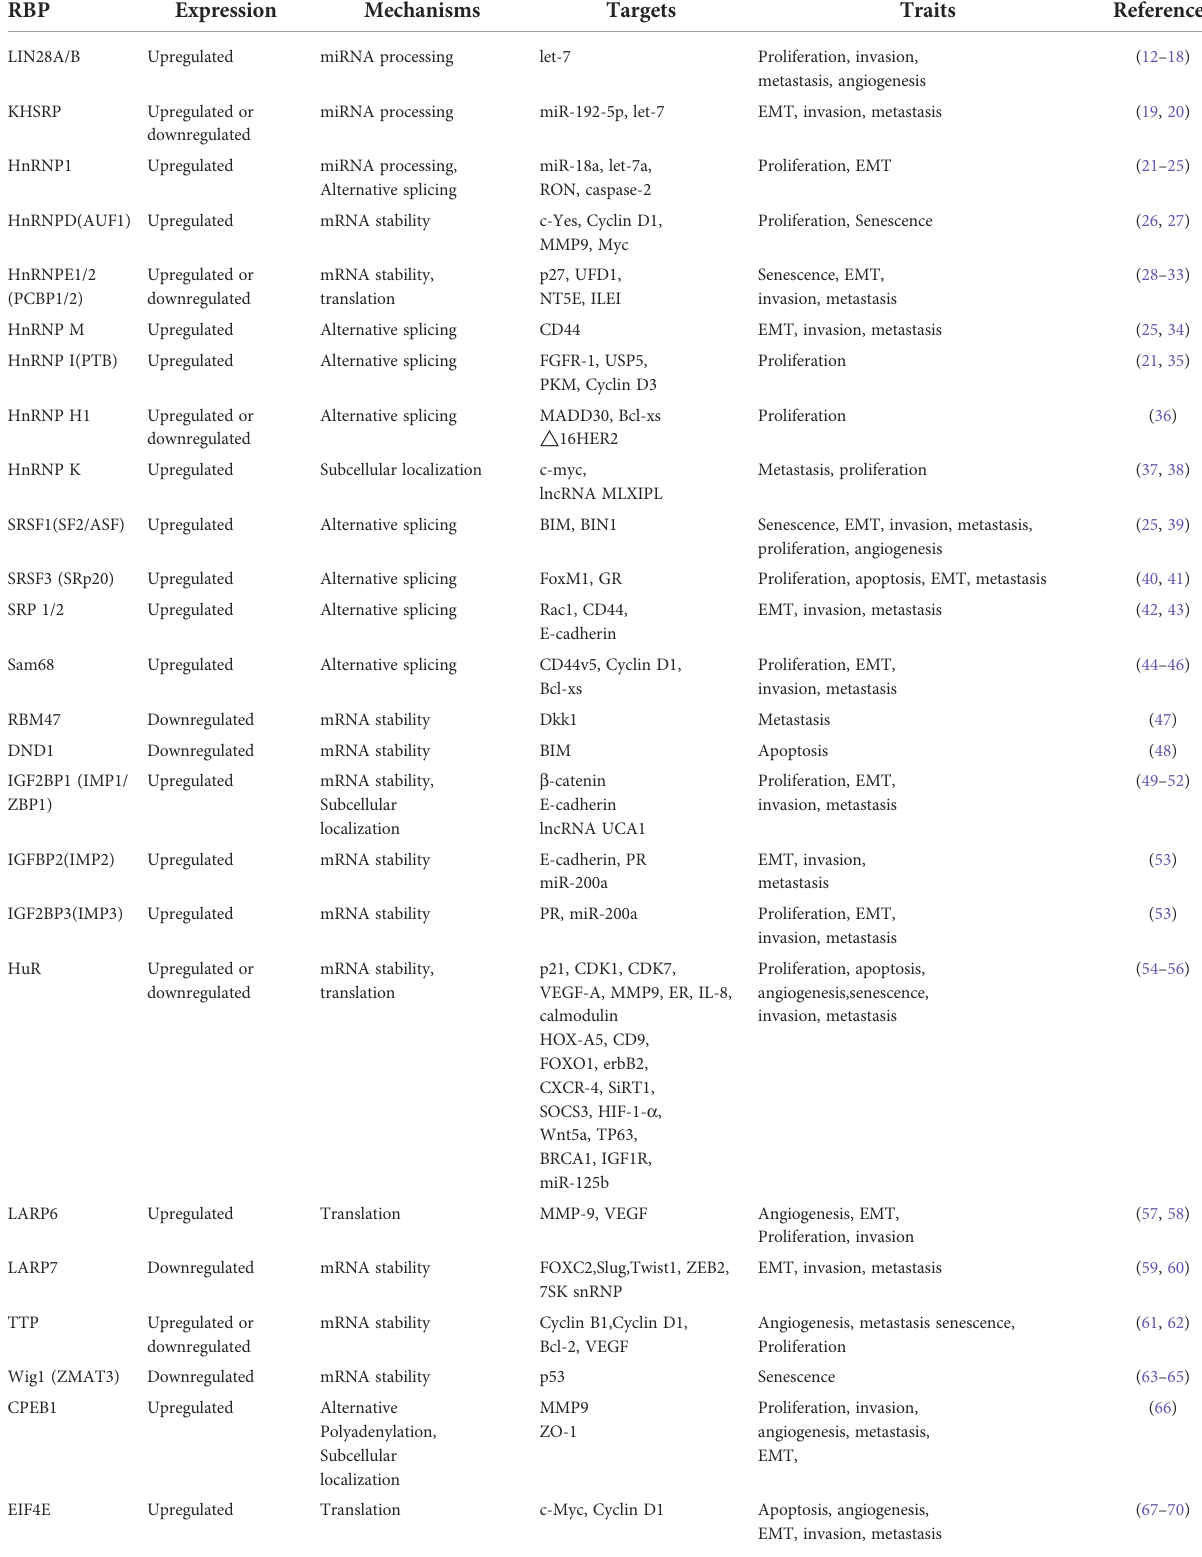
TABLE 1 Roles of RNA binding proteins (RBPs) in breast